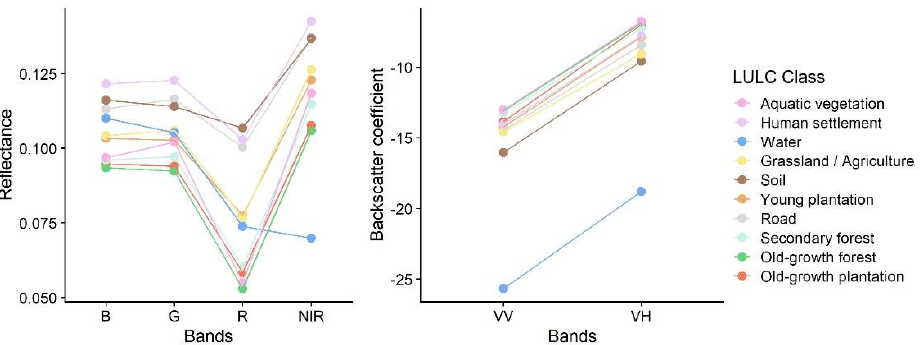
Figure 6. Mean spectral signal of the twelve classes included in the land use/land cover (LULC) classification system.